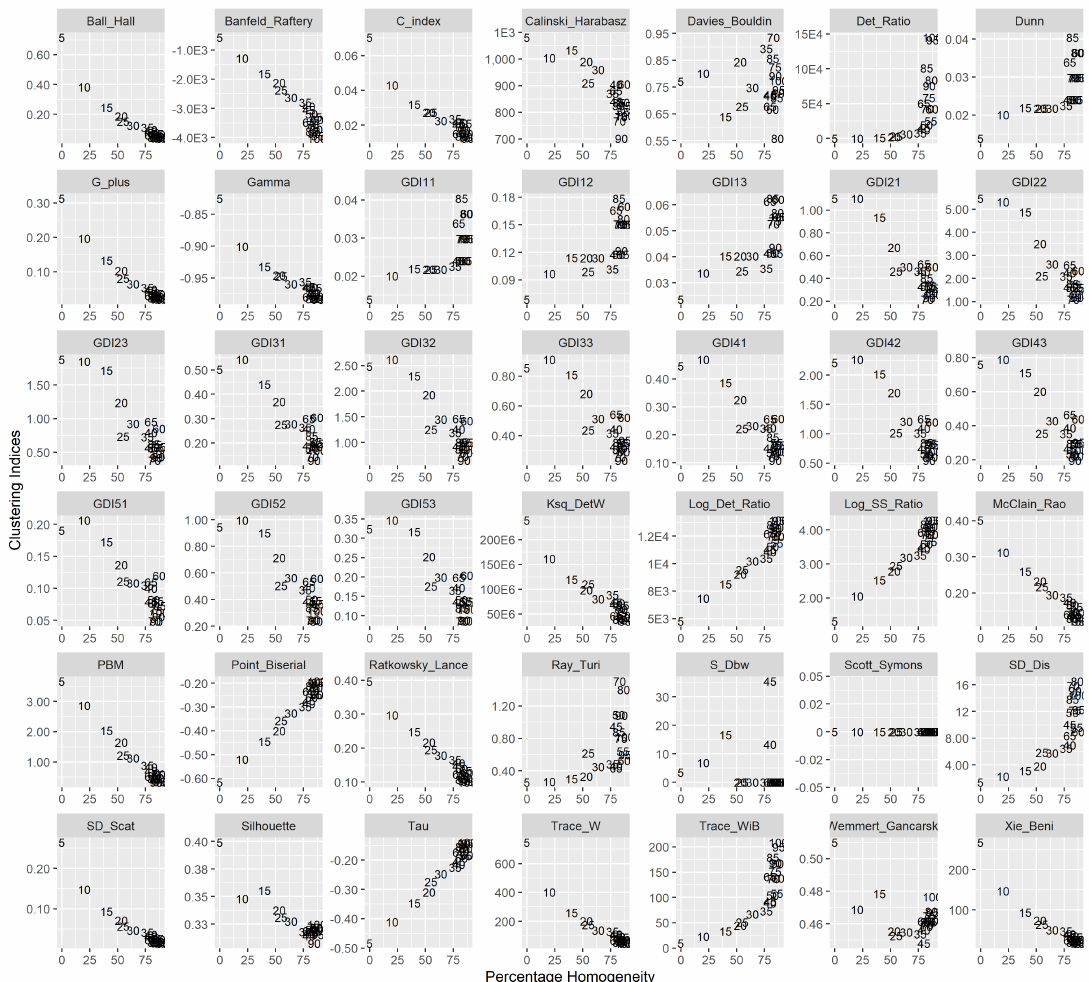
Figure 7. Performance of cluster validity indices in Prairie region—Summer Season. The numbers indicate the percentage homogeneity for the number of clusters in the x-axis and index value on the y-axis. The scientific notation ‘E’ used in labels of y-axis represent ‘10 to the power